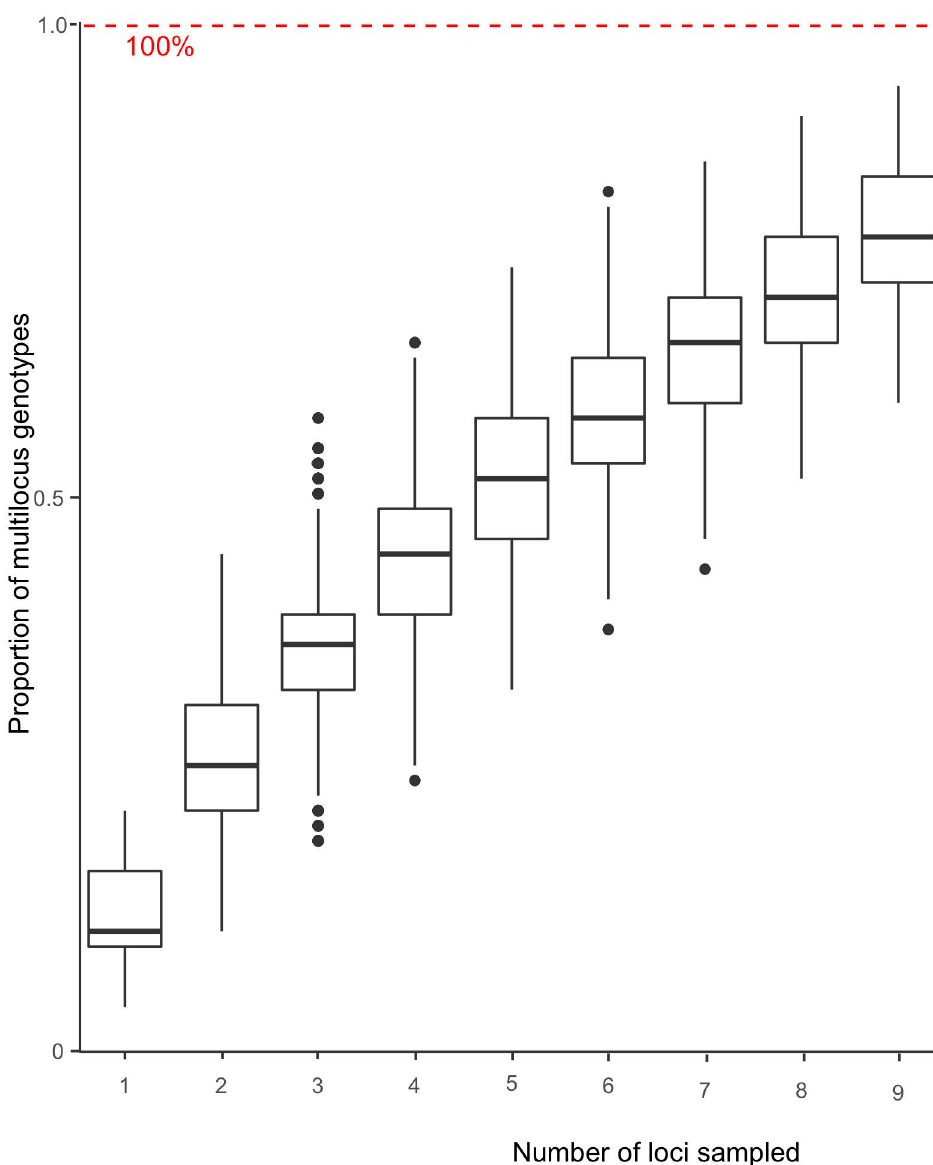
Fig 1. Genotype accumulation curve for C . cassiicola . Proportion of multilocus genotypes identified based on the number of loci sampled. There were 1,000 randomizations of the data analyzed in poppr package executed in R [45].